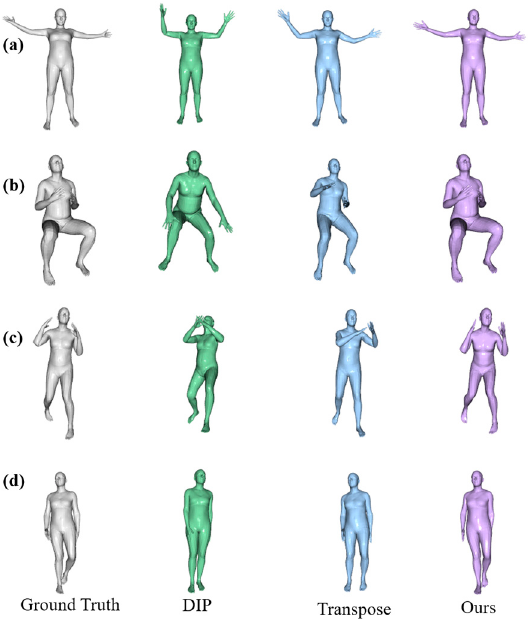
Figure 6. Qualitative results of our results compared to other methods on the DIP-IMU dataset. The results are “Ground Truth”, “DIP “, “Transpose” and “Ours” from left to right. Samples ( a , b ) show the reconstruction of the upper body by our network. The samples of ( c , d ) show the reconstruction of the lower body by our network.